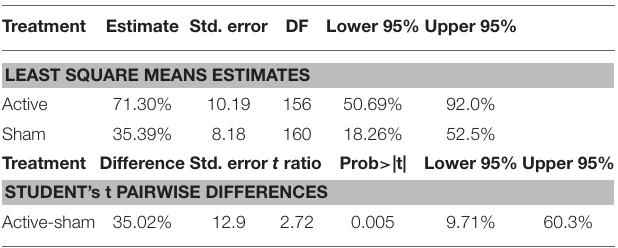
TABLE 3 | Percent decrease in opioid craving score from visit 1 to 11 by mixed model analysis. Treatment Estimate Std. error DF Lower 95% Upper